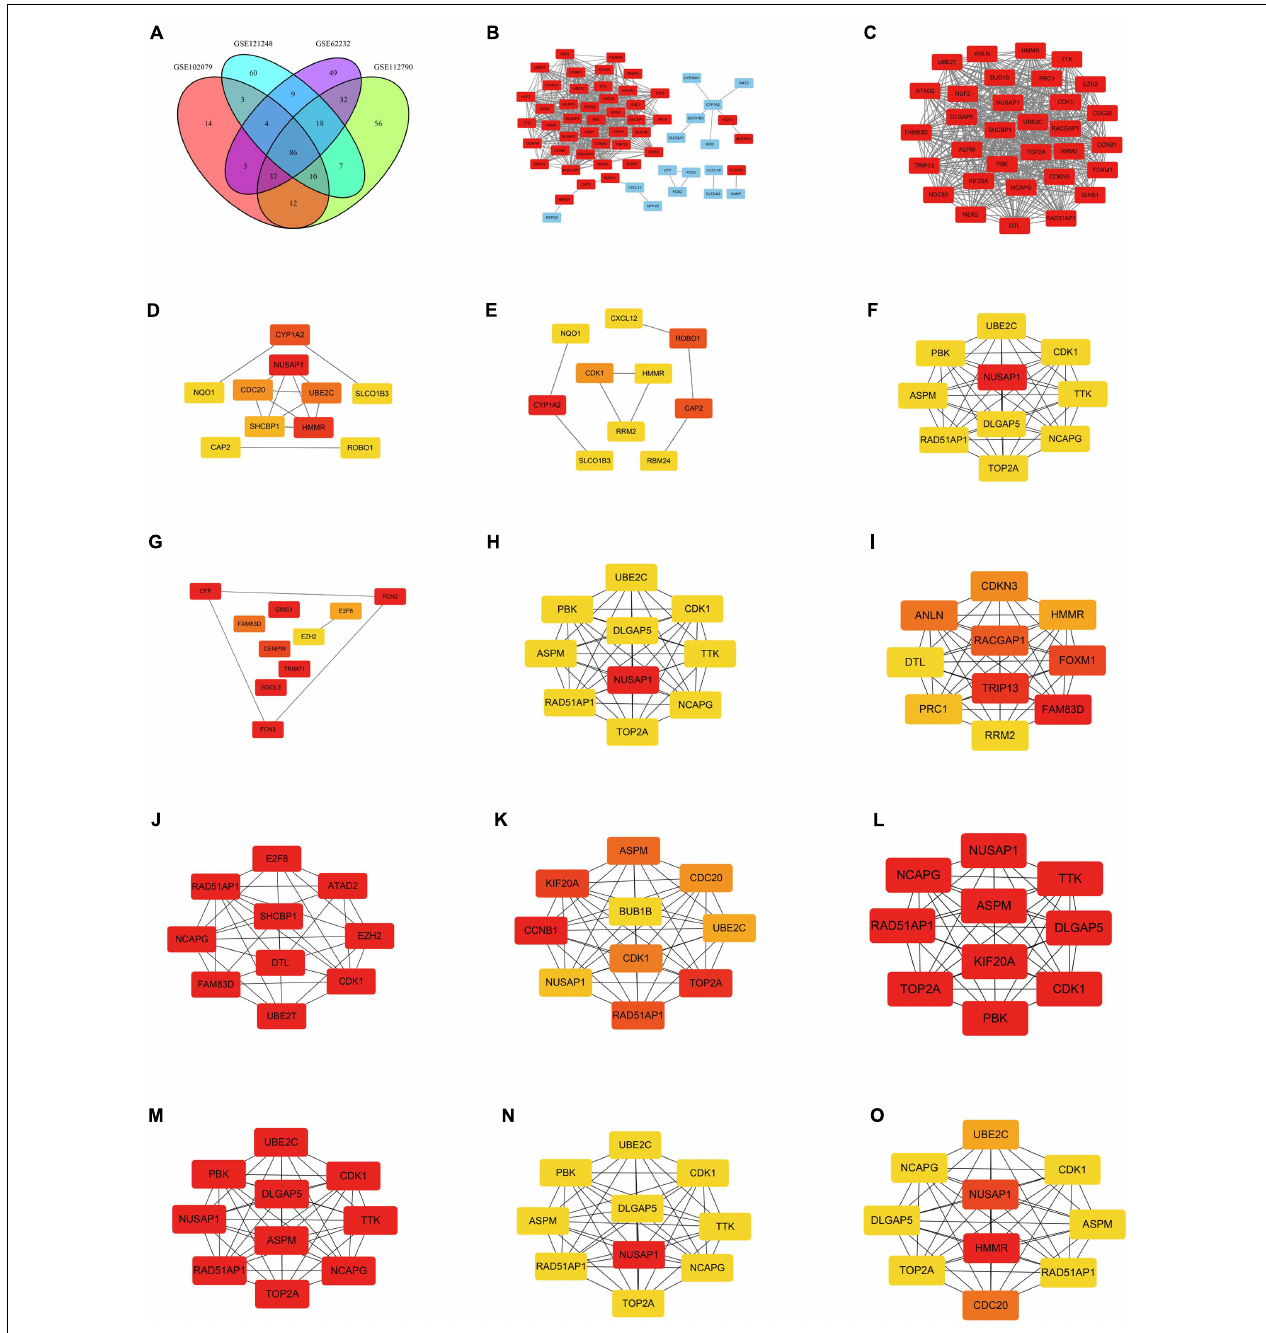
FIGURE 2 | Venn diagram and PPI networks. (A) Identification of overlapping DEGs in GSE62232, GSE102079, GSE112790, and GSE121248; the four datasets shared 86 overlapping DEGs. (B) PPI network was constructed using 86 overlapping DEGs (including 55 upregulated genes and 31 downregulated genes). Upregulated and downregulated genes were marked in red and blue, respectively. (C) The most significant module of PPI network included 32 nodes and 474 edges. All genes in the most significant module were upregulated genes and marked in red. (D) Top 10 hub genes in the PPI network, which were calculated by method Betweenness. (E) Top 10 hub genes in the PPI network, which were calculated by method BottleNeck. (F) Top 10 hub genes in the PPI network, which were calculated by method Closeness. (G) Top 10 hub genes in the PPI network, which were calculated by method ClusteringCoefficient. (H) Top 10 hub genes in the PPI network, which were calculated by method Degree. (I) Top 10 hub genes in the PPI network, which were calculated by method DMNC. (J) Top 10 hub genes in the PPI network, which were calculated by method EcCentricity. (K) Top 10 hub genes in the PPI network, which were calculated by method EPC. (L) Top 10 hub genes in the PPI network, which were calculated by method MCC. (M) Top 10 hub genes in the PPI network, which were calculated by method MNC. (N) Top 10 hub genes in the PPI network, which were calculated by method Radiality. (O) Top 10 hub genes in the PPI network, which were calculated by method Stress. The darker the color, the higher the